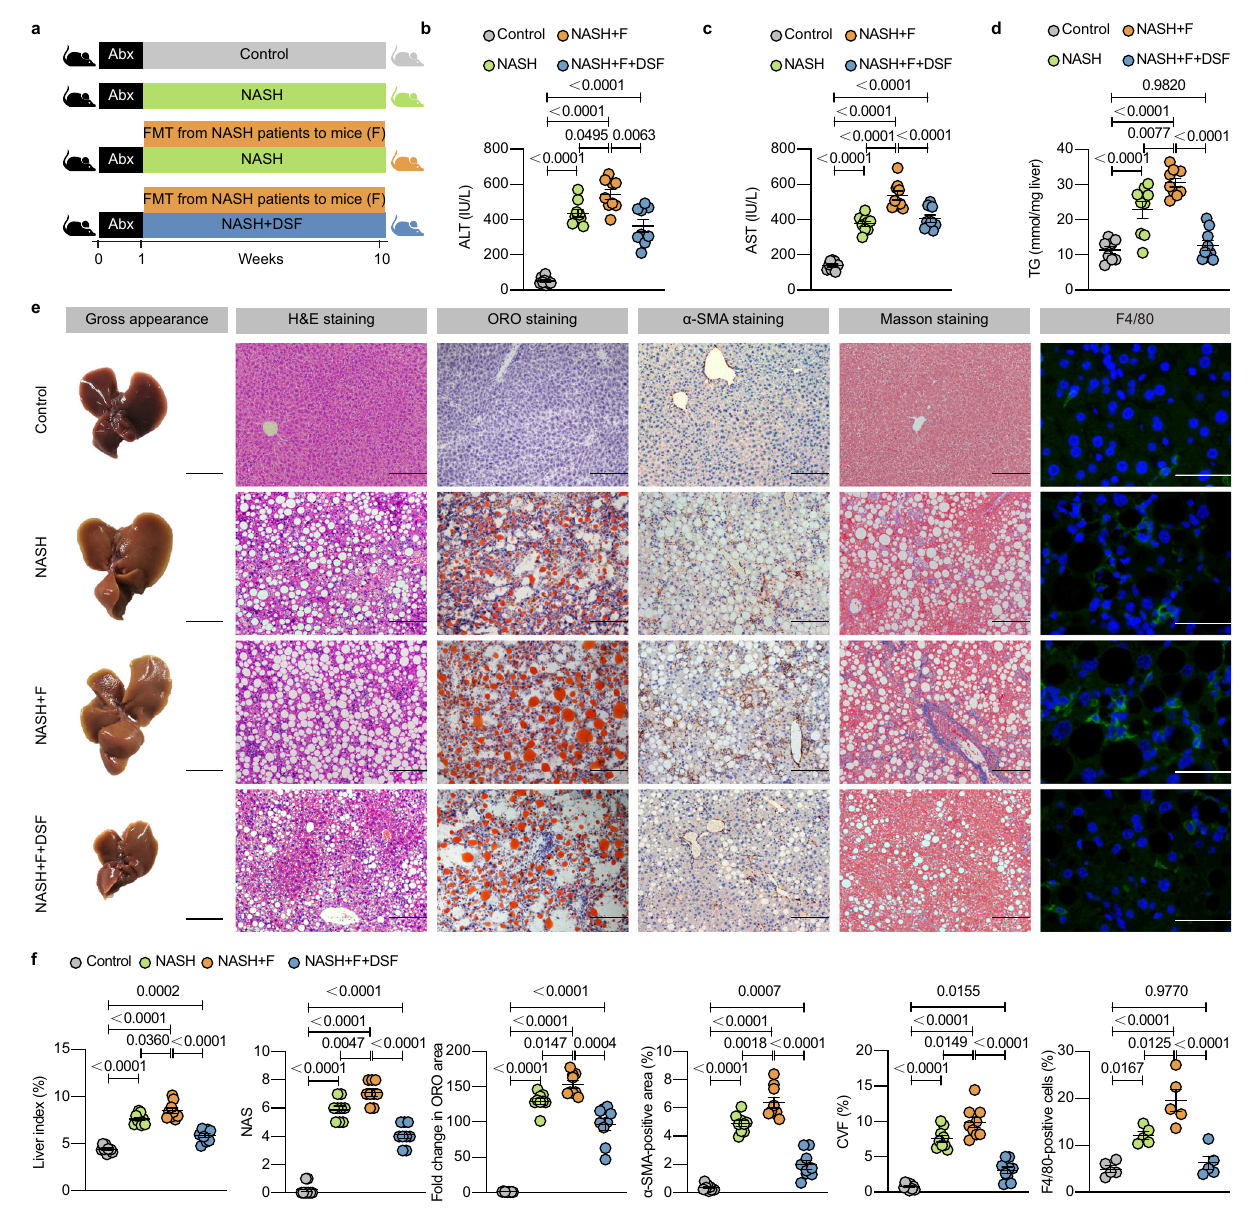
Fig.2|DSFhaspotentialamelioratingeffectsonmicehumanizedwiththefecal microbiota from NASH patients. a HMA experimental design. WT mice were put on a course of intragastrically Abx administration for 1 week and then randomized into 4 groups (control, NASH, NASH+F and NASH+F+DSF) under a control diet, CDAHFD, CDAHFD and CDFHFD+DSF, respectively for 9 weeks. NASH+F and NASH+F+DSF mice were colonized with two NASH patients-derived fecal micro- biotafor9weekstoworkinthecontextsofthehumanmicrobiota. b – d SerumALT and AST; hepatic TG. e Representative images of gross appearance of the liver histology (1cm) and photomicrographs of fi xed liver sections after staining with H&E (200 μ m), ORO (200 μ m), α -SMA antibody (200 μ m), Masson (200 μ m) and F4/80antibody (50 μ m). f Quanti fi cation of theliver index (%),NAS,foldchange in